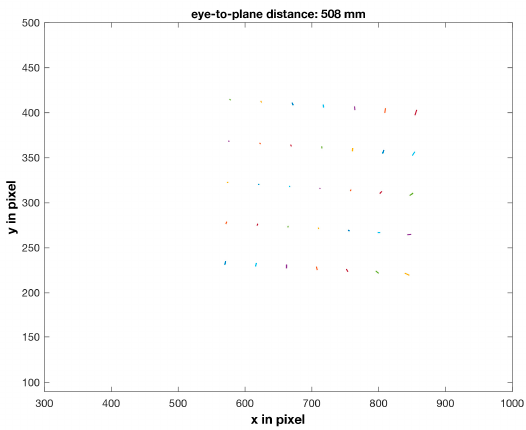
Figure A5. Map of disparities for a target plane placed at 508 mm from the observer.